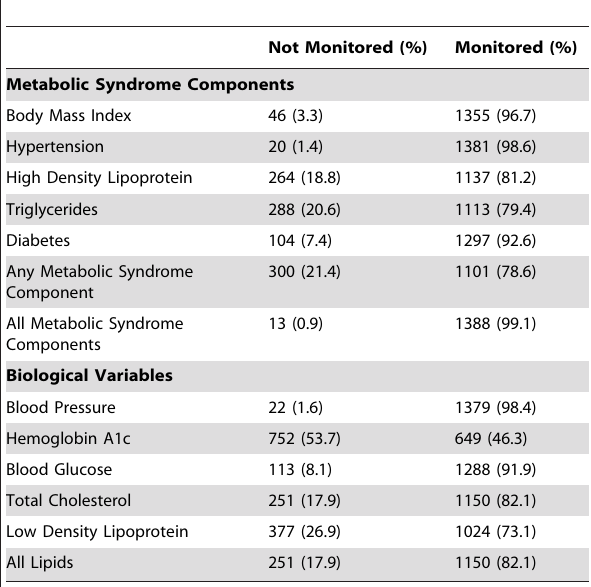
Table 2. Monitoring of Metabolic Syndrome Components (n=1401).